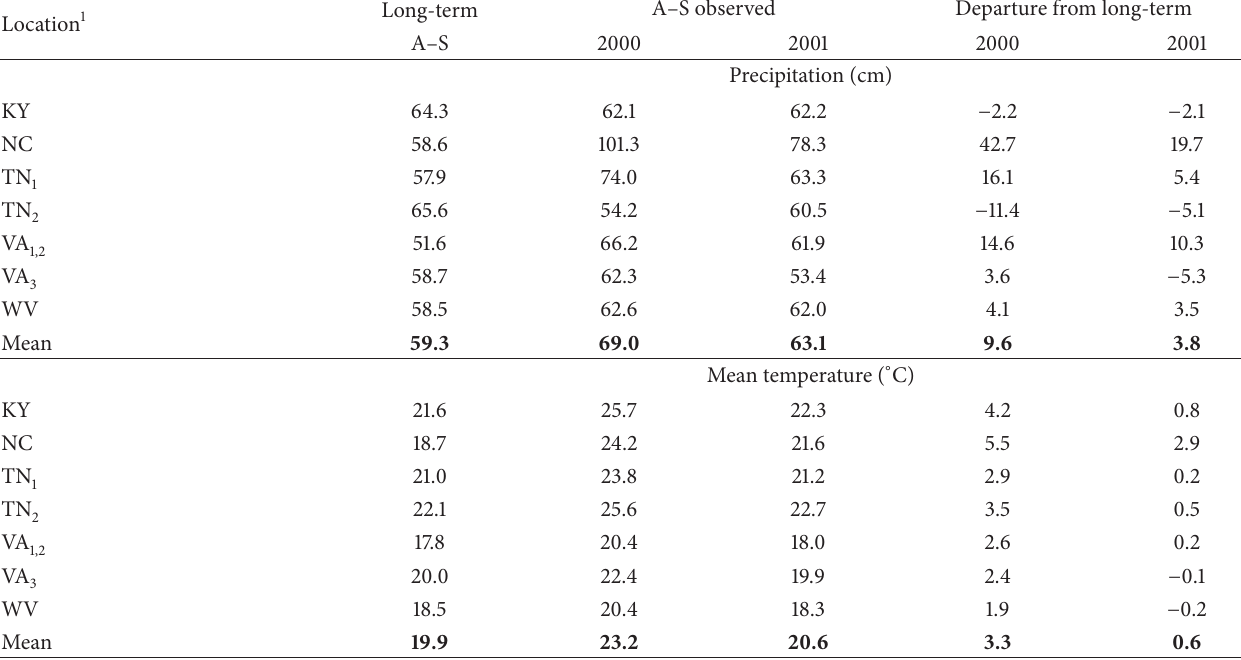
Table 4: Observed and long-term means for rainfall and temperature data during April through September (A–S) near sites on which switchgrass was grown in the upper Southeast USA. Departure from long-term (30yr) normal was obtained by subtracting total precipitation and mean temperature from their respective long-term